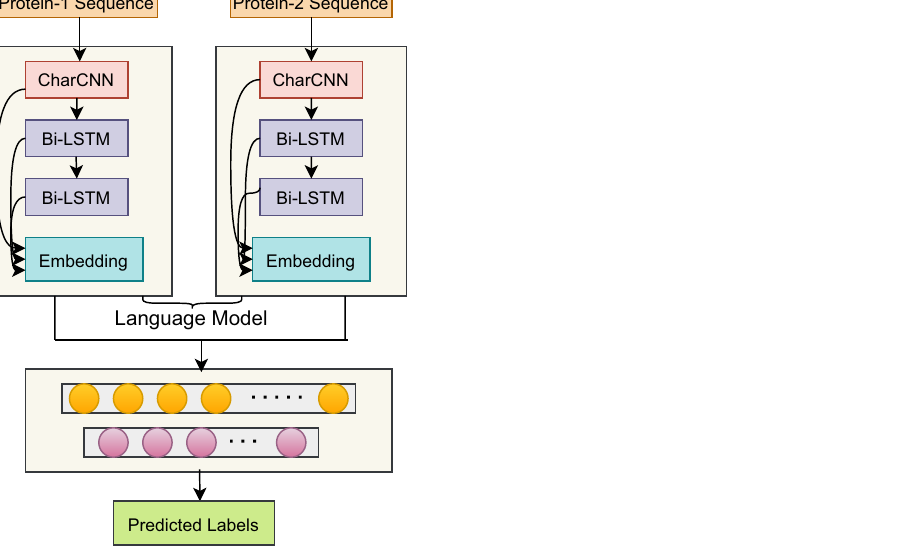
Figure 4. Illustration of the designed baseline.